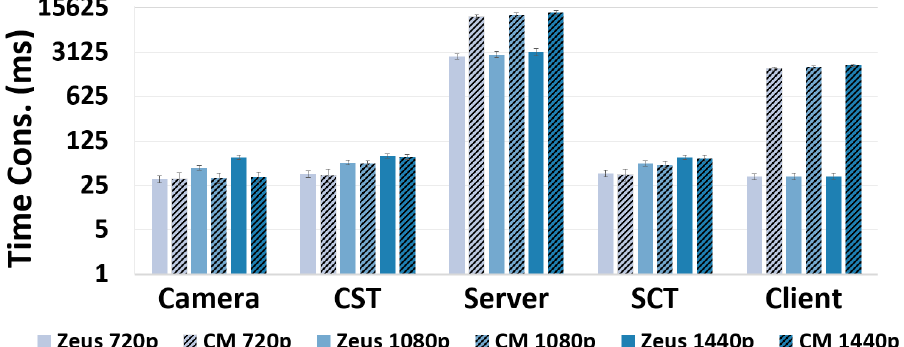
Figure 20. Comparison of component time between Zeus and a commercial system (denoted by